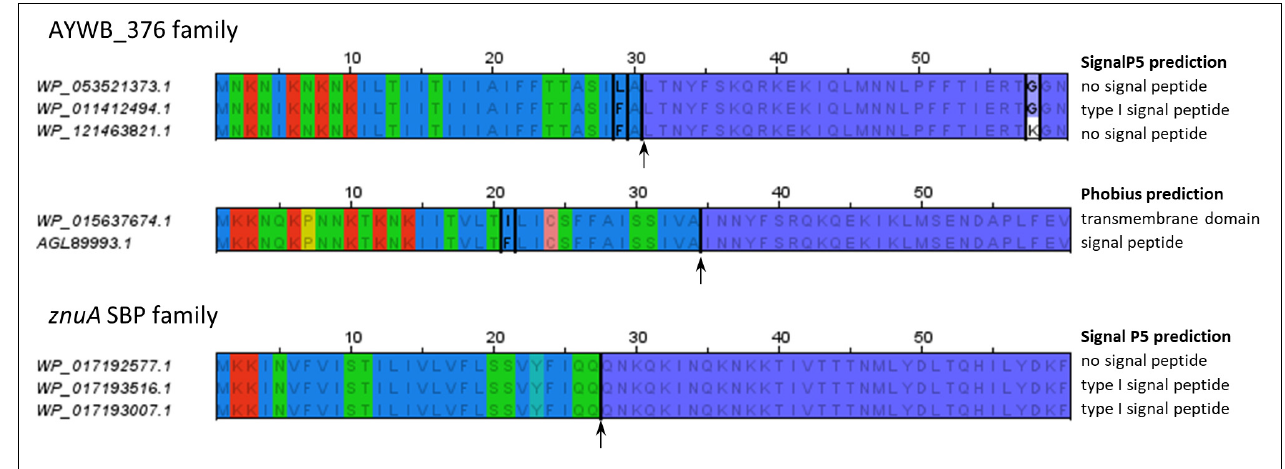
FIGURE 5 | Similar N-terminal sequences with different signal peptide predictions. The alignments only show the first 60 residues of each sequence. Residues conserved within an alignment are written in gray; accession-specific residues are in black and boxed. The alignment of sequences from znuA gene family shows no sequence variation. Background colors follow the same color code as in Figure 1 . Putative cleavage sites (according to SignalP5 or Phobius as required) are indicated by an arrow. Mentions on the right of the alignments indicate the respective predictions of SignalP5 or Phobius for each sequence.